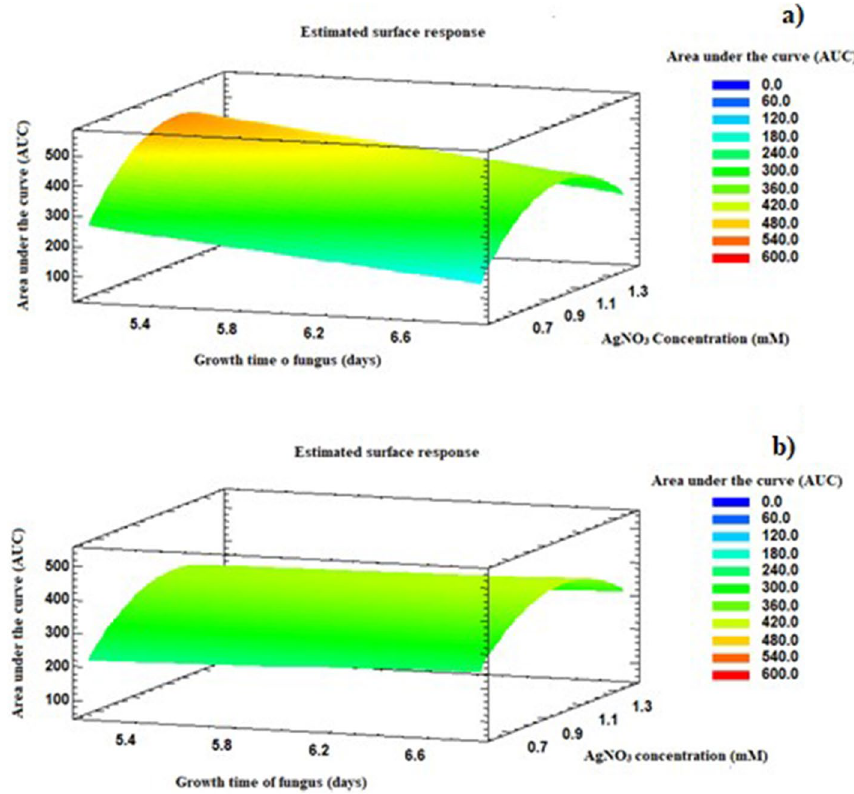
Figure 3. Response surface graphs for ( a ) t = 120 h ( b ) t = 144 h.